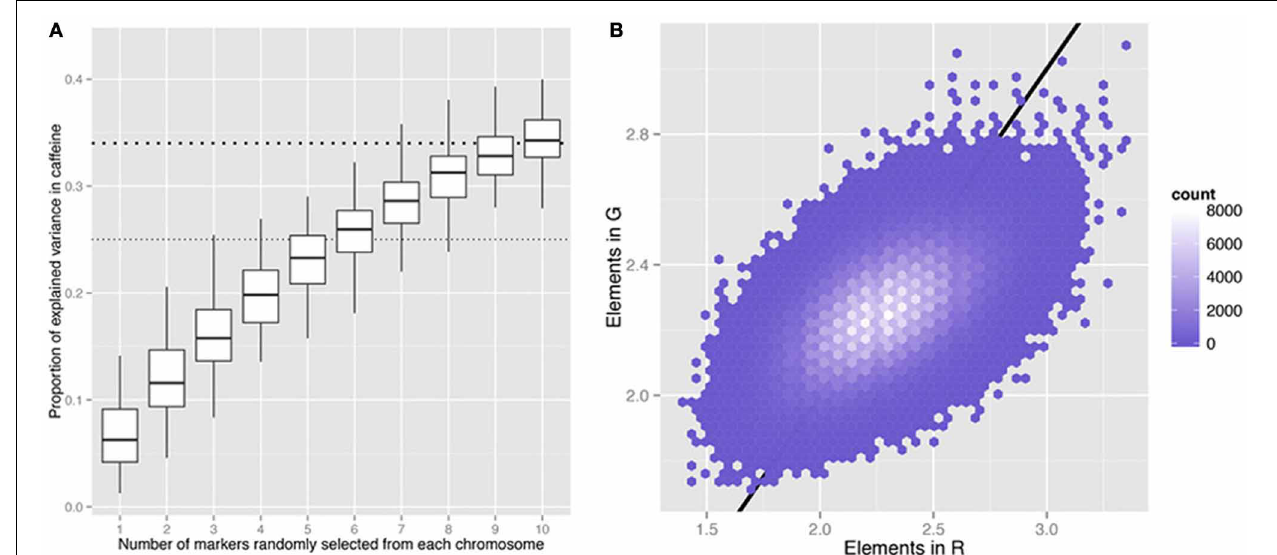
FIGURE 1 | Information captured by randomly selected markers in the yeast cross 6 . (A) Proportion of variance explained in the caffeine phenotype by different numbers of randomly selected markers across the genome. Hundred times of random sampling were replicated for each value on the x -axis. The thick and thin horizontal dashed lines indicate Bloom et al.’s 6 estimates of the total narrow sense heritability ( h 2 ) and the h 2 explained by their detected QTL. (B) Comparison of the elements in the genomic kinship